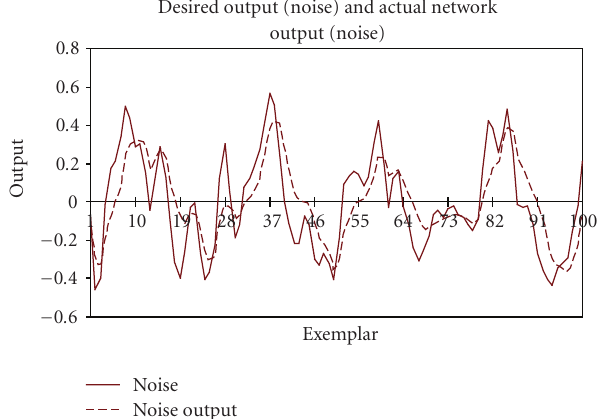
Figure 15: Modeling capability of RBF on test dataset of EMG noise signal.